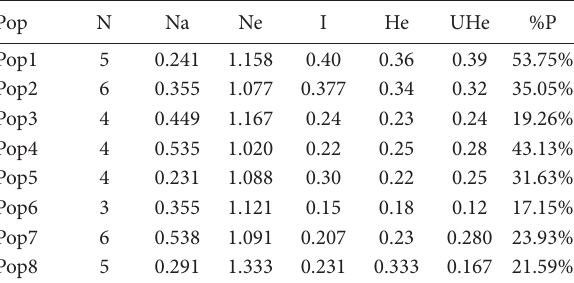
Table 3. Genetic diversity parameters in the studied populations Pistacia khinjuk (N = number of samples, Na= number of different alleles; Ne = number of effective alleles, I= Shannon’s information index, He = gene diversity, UHe = unbiased gene diversity, P%= percentage of polymorphism, populations).